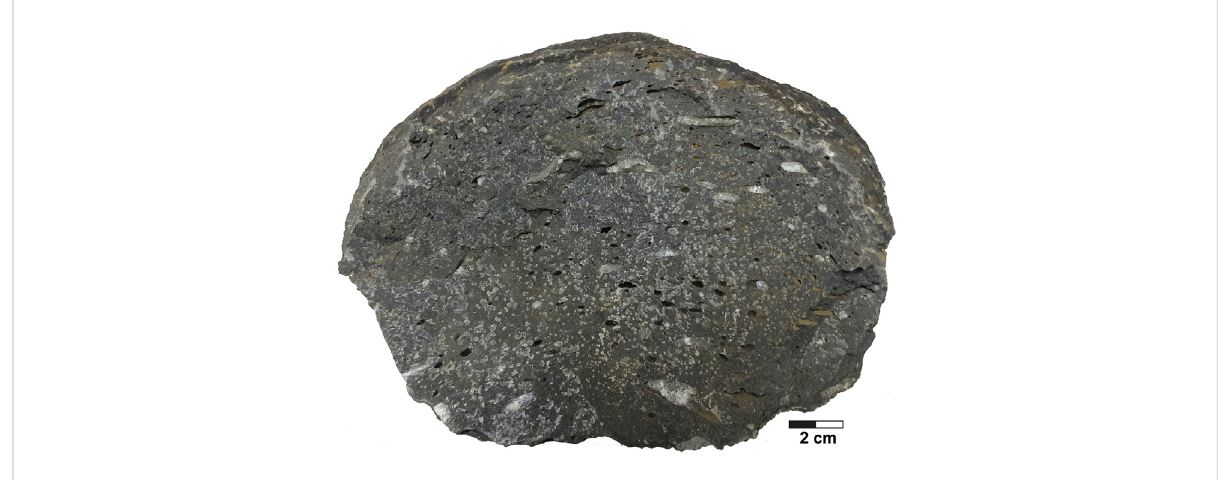
FIGURE 6 An example of the vesicular basalt from the Buriram-Nakhon Ratchasima area in the Khorat